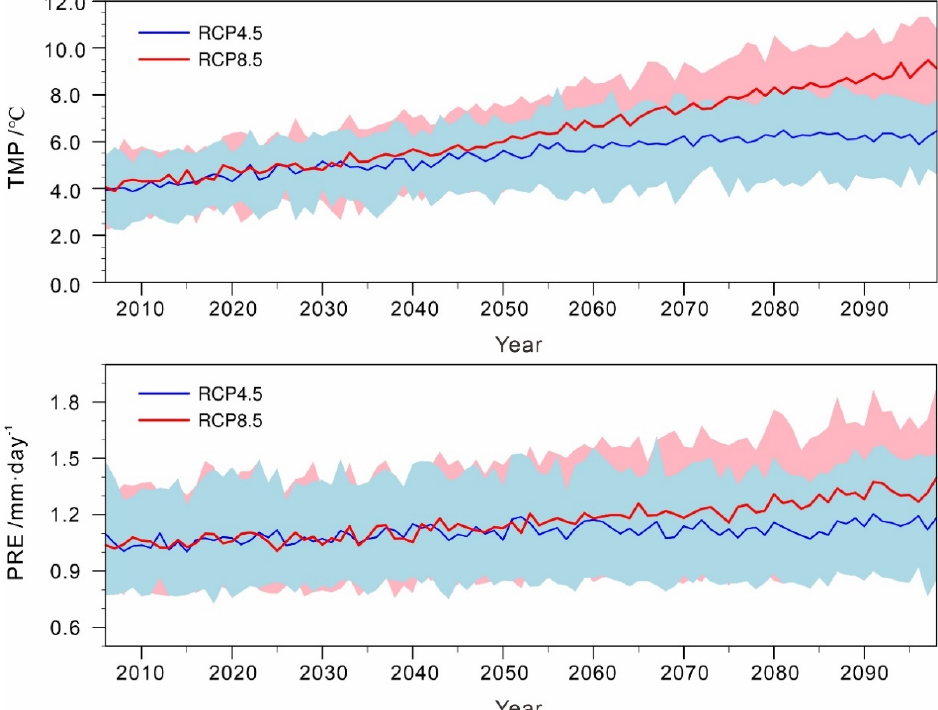
Figure 5. Time series of ensemble mean TMP and PRE simulations in CEA during the period 2006–2098 under two different scenarios (RCP4.5 and RCP8.5). Lines indicate the CMIP5 multimodal mean, and shades show the ranges of minimum and maximum values of TMP and PRE for the multimodal simulation, respectively.